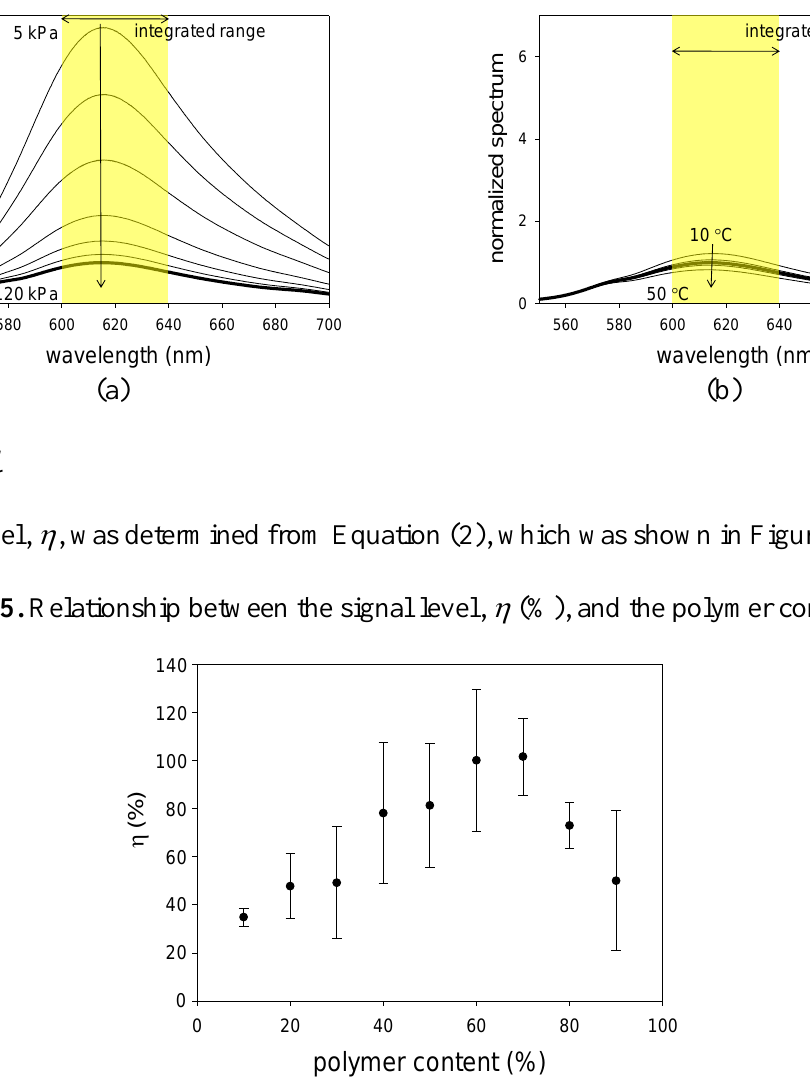
Figure 4. ( a ) Pressure spectra and ( b ) temperature spectra of PCPSP*. Thick line shows the spectrum at the reference conditions of 100 kPa and 25  C.